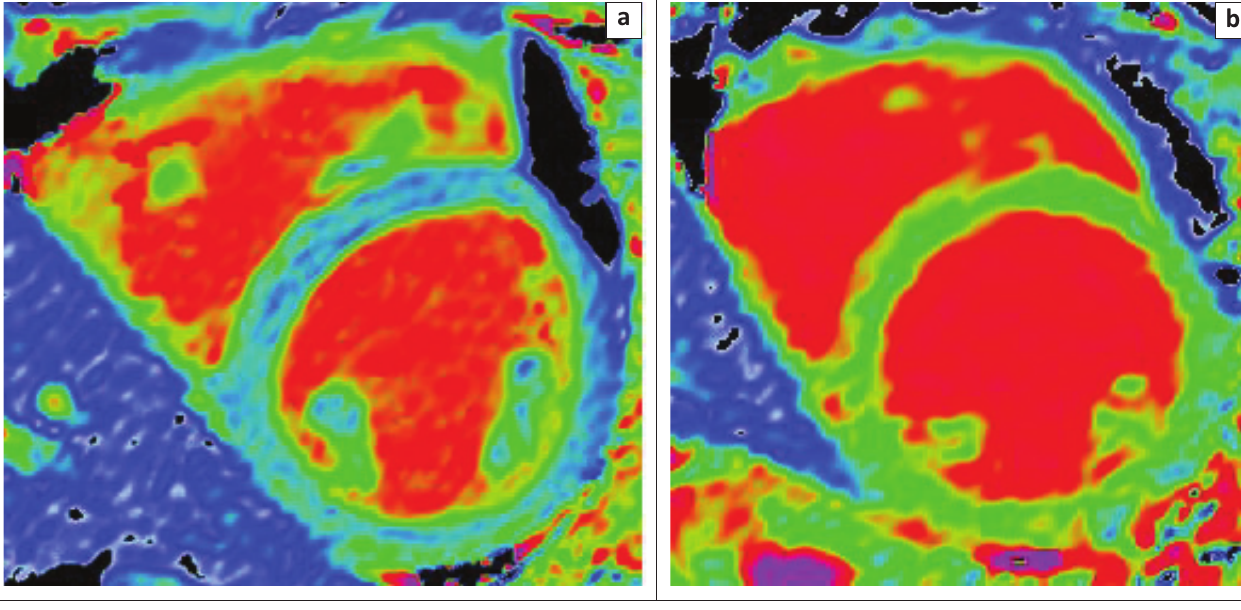
FIGURE 6: T1 map in severe iron loading (a) and a normal T1 map (b). As in Fabry’s, T1 is low and T1 map appears blue but here there is no